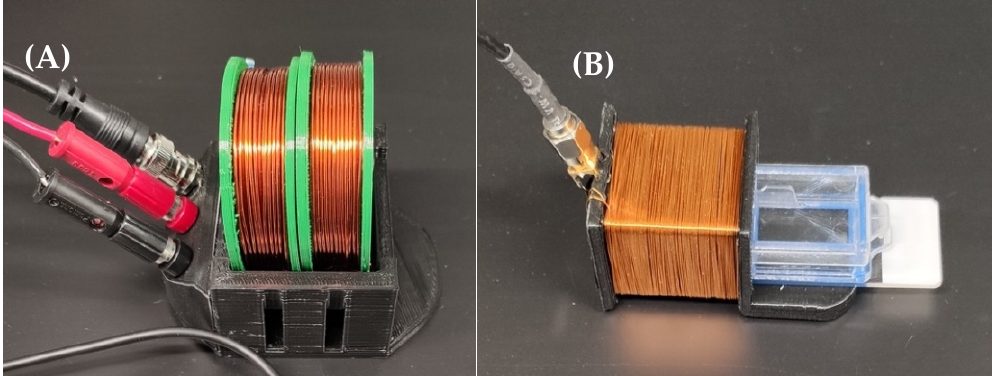
Figure 4. The DC bias coil ( A ) and detection coil ( B ) used in this experiment. During measurement, the detection coil is placed in the DC bias coil, such that the two coils are concentric. The exposed portion of the chamber slide is not used, as the sensor is only placed in the chamber that is completely inserted into the detection coil.